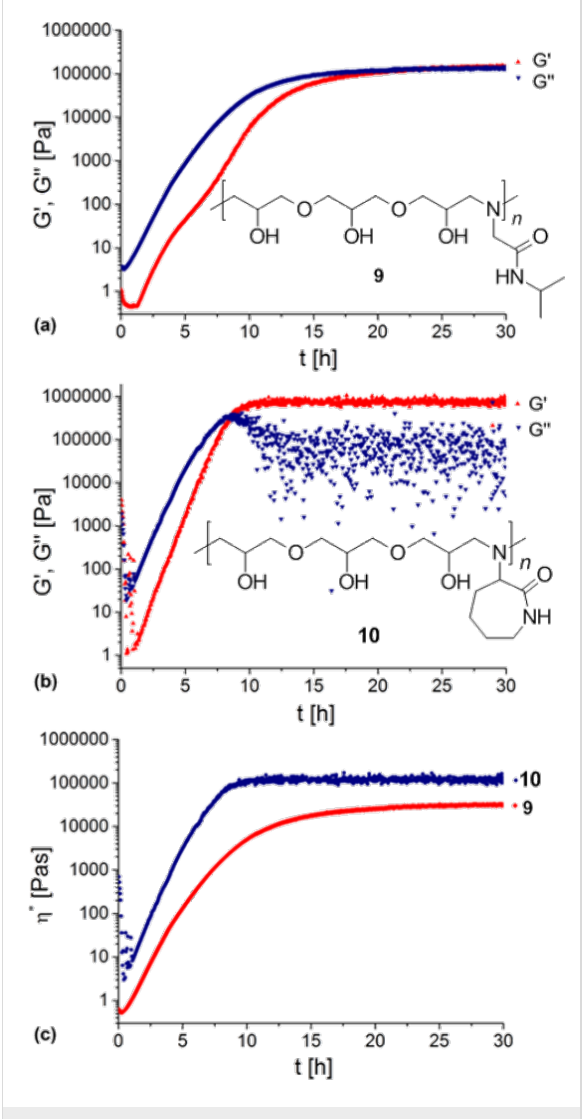
Figure 4: Oscillatory rheological measurements of the curing of 9 and 10 , respectively at 25 °C. Illustrated are exemplary G’ and G’’ plots as a function of time for 9 (a) and 10 (b), as well as a comparison of the complex viscosity of 9 and 10 (c).